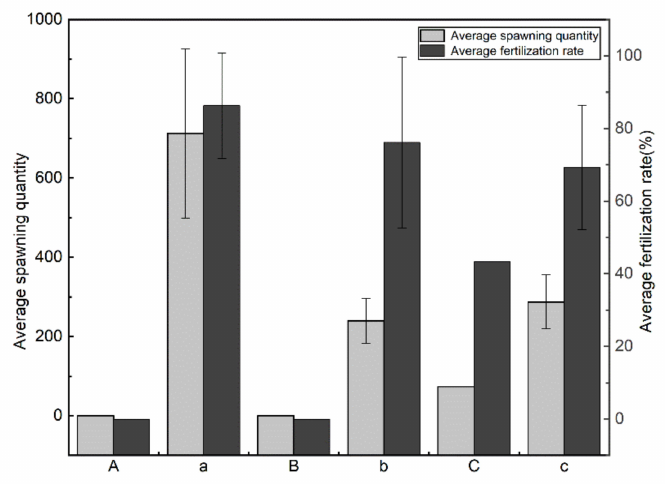
Figure 7. Average spawning quantity and fertilization rate of each group. ( A – C ) The blank group, sand group, and mud group, respectively; ( a – c ) the above groups after adding